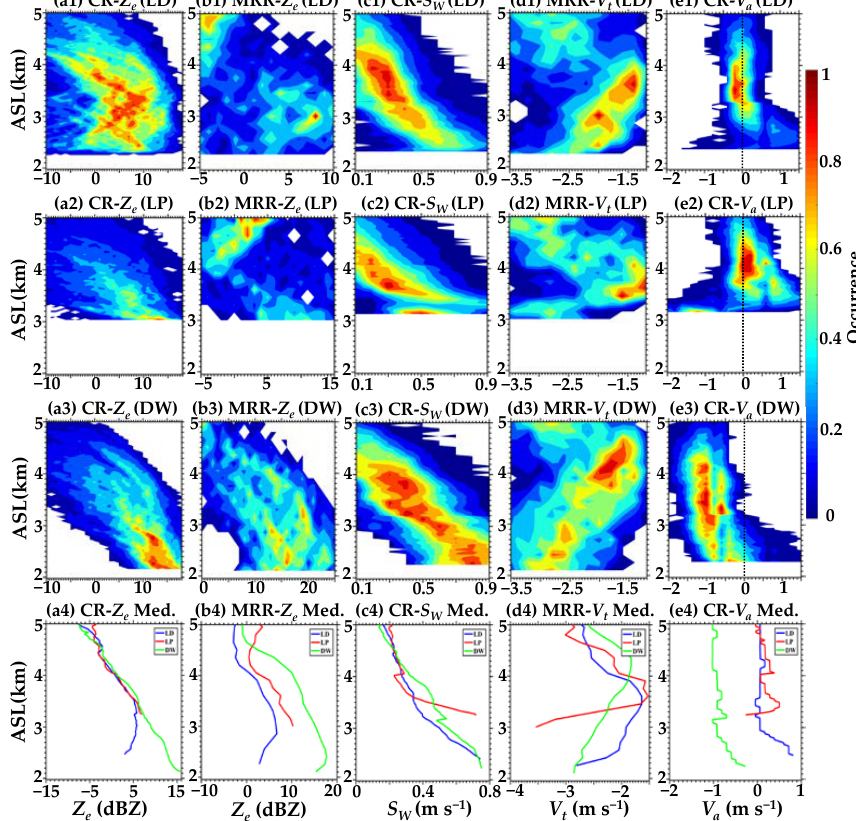
Figure 7. Normalized contoured frequency by altitude diagrams (NCFADs) of equivalent reflectivity factor ( Z e , dBZ), spectrum width ( S W , m s − 1 ), and vertical air velocity ( V a , m s − 1 ) are measured by the CR, and Z e (dBZ) and particle falling velocity ( V t , m s − 1 ) are measured by MRR for the shallow cloud and precipitation stage. Subfigures ( a1 – e1 ), ( a2 – e2 ) and ( a3 – e3 ) represent the results at the LD, LP, and DW sites, respectively, and ( a4 – e4 ) denote median profiles (Med.) of radar variables. The black dotted line represents the 0 m s − 1